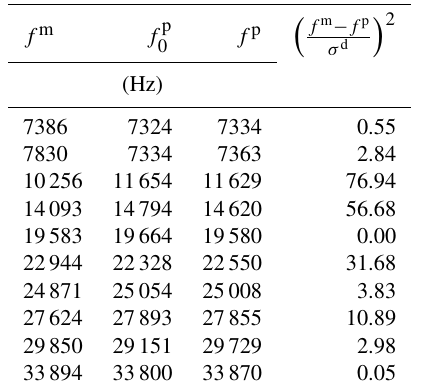
Table 1. Measured ( f m ), initial-model-predicted ( f p model-predicted ( f p ) resonant frequencies for our sample at − 25 ◦ C. The final column is the relative contribution of each peak to the overall χ 2 .